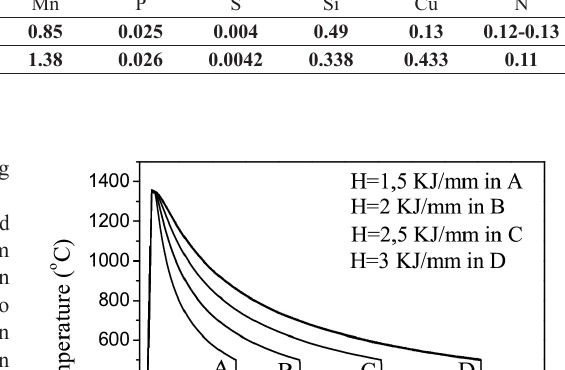
Table 1. Chemical composition (wt.%) of the two DSSs (UNS S31803 and UNS S32304). Elements